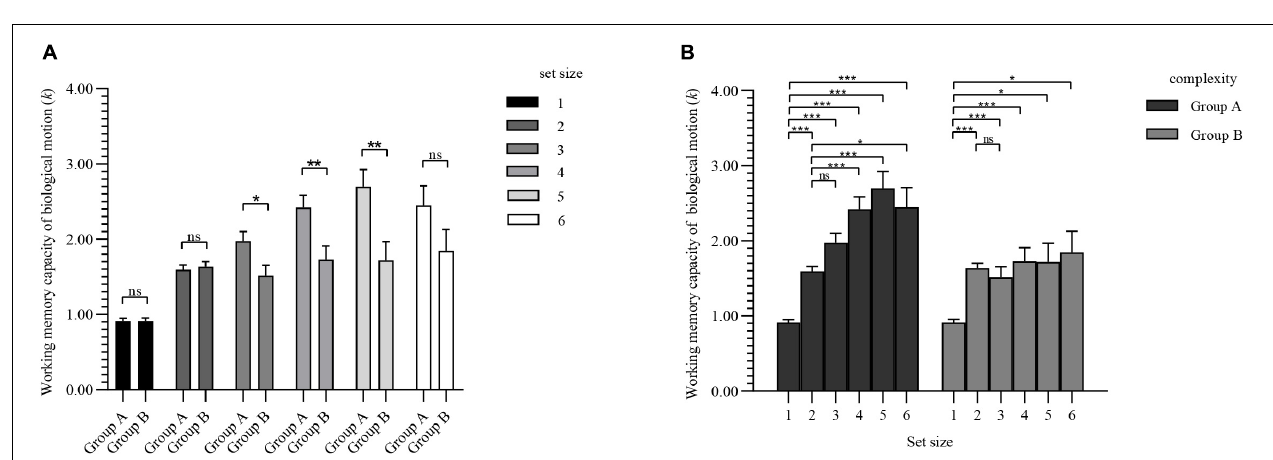
FIGURE 5 | WMC of BM for each group of experiment 3. Values are reported as mean ± standard error.